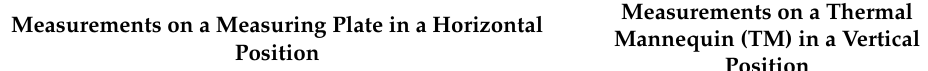
Table 2. Summary of the Tests Showing Measuring Systems, Test Positions, Order, Material Type and the Direction of the Heat Flux q.